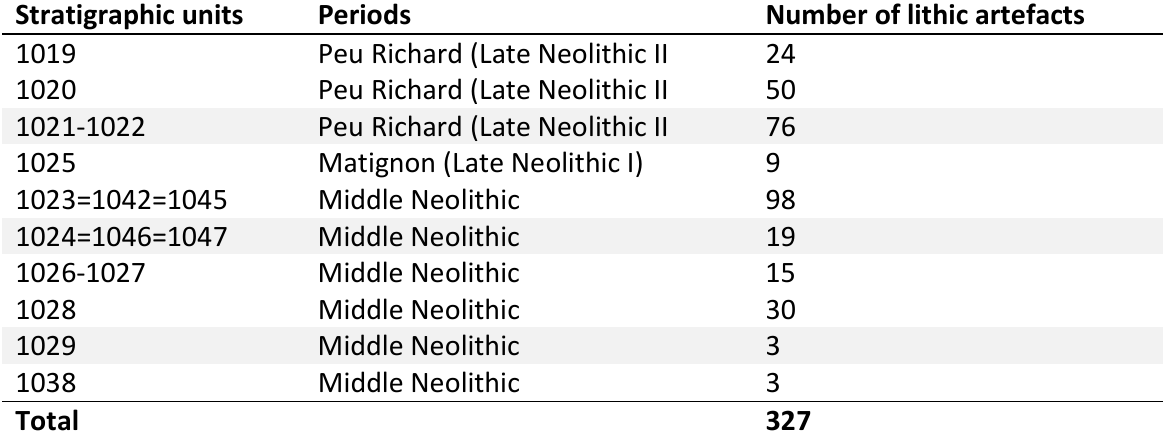
Table 2. Number of lithic artefacts per period and per Stratigraphic